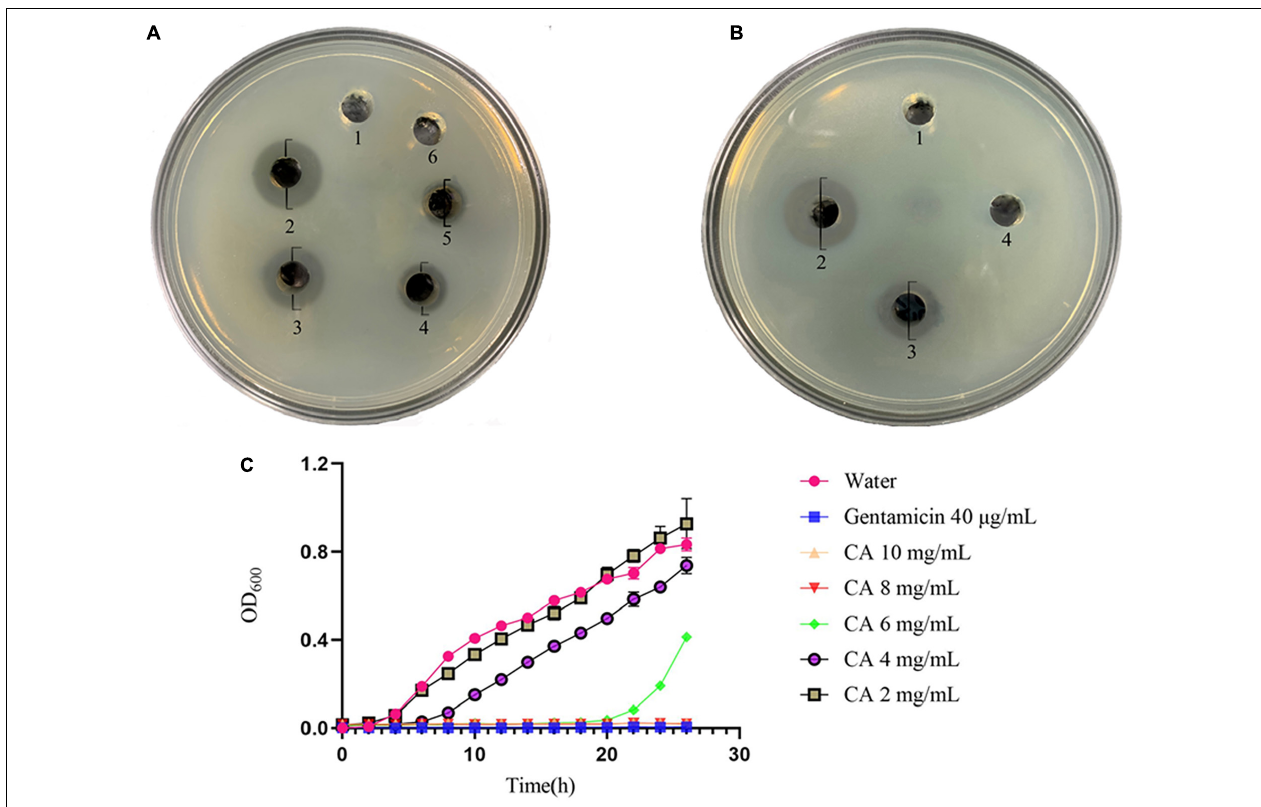
FIGURE 1 | Antibacterial effect of CA against Y. enterocolitica . (A) Inhibition zones by water (1), 40 µ g/mL gentamicin (2), 80 mg/mL CA (3), 60 mg/mL CA (4), 40 mg/mL CA (5), and 20 mg/mL CA (6). (B) Inhibition zones by water (1), 40 µ g/mL gentamicin (2), 80 mg/mL CA (3), and PBS with pH of 2.5 (4). (C) Growth curves of Y. enterocolitica treated with water, gentamicin, and different concentrations of